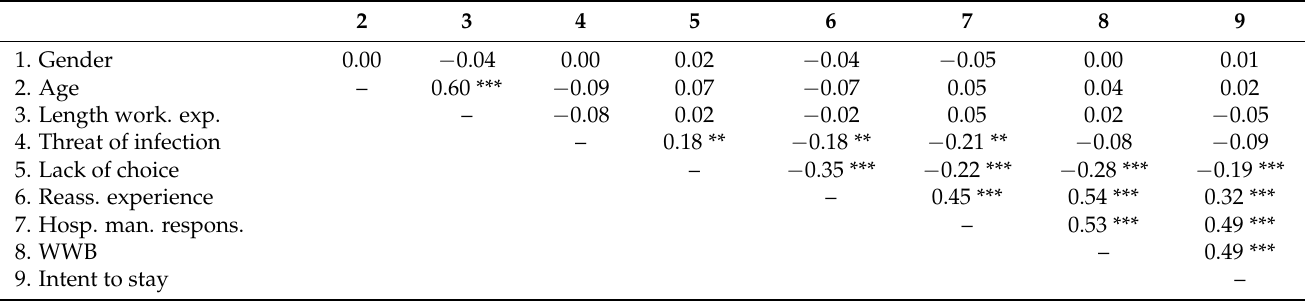
Table 2. Correlations (Pearson for continuous variables and Spearman for the ordinal variable) among the main study variables and confounding